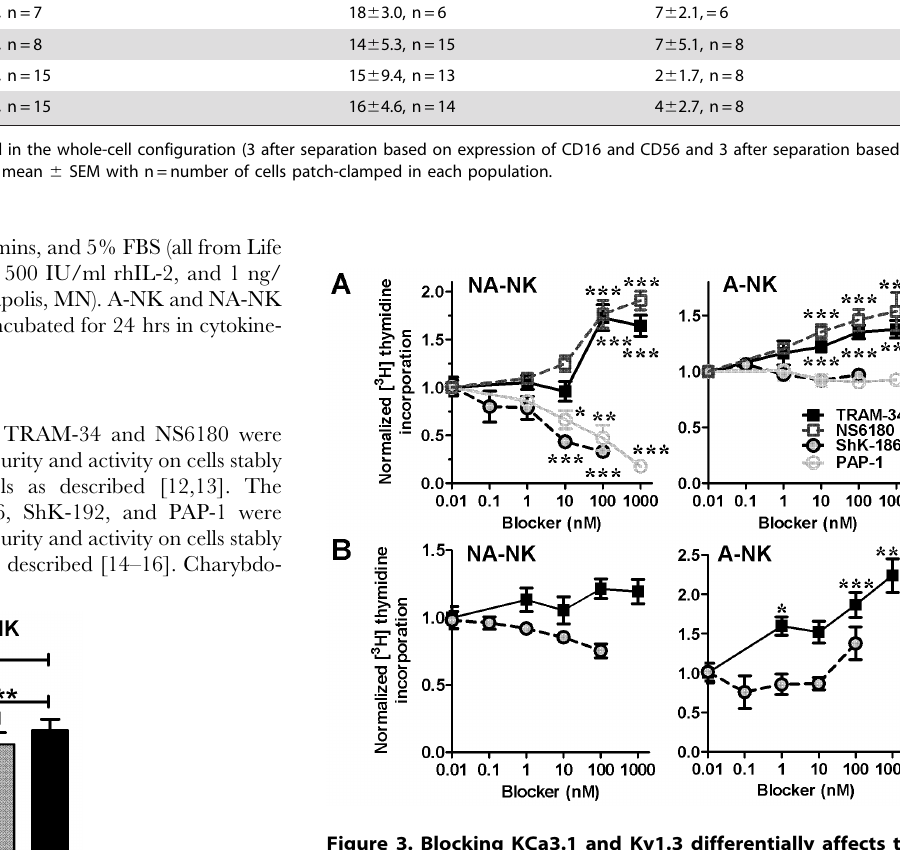
NK cell subset % that express both Kv1.3 and KCa3.1